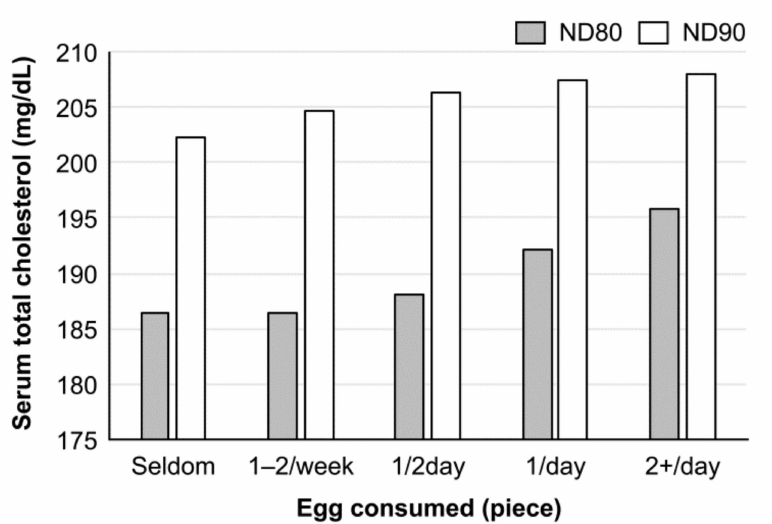
Figure 2. Relationship between egg consumption and serum cholesterol level in Japanese women (observation studies). Cholesterol levels were adjusted with age, body mass index (BMI), smoking, and alcohol intake. There was a significant association between egg consumption and serum choles- terol levels in NIPPON DATA 80 ( p < 0.001), but the association disappeared in NIPPON DATA90 ( p = 0.63). In both studies, the association was not observed in men. The order of egg consumption was reversed from the original figure in reference